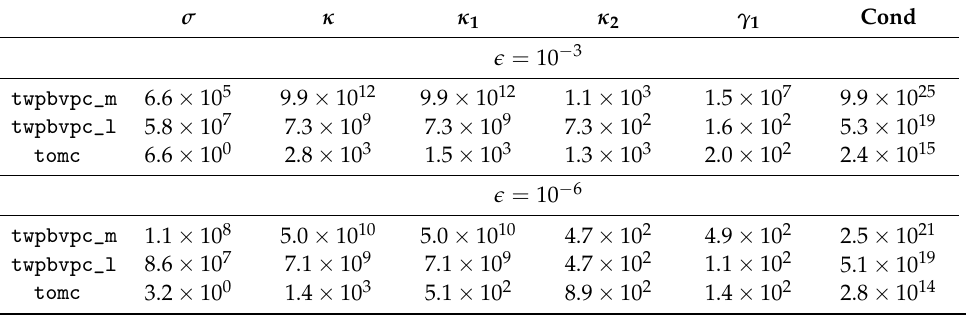
Figure 6. Minimization of the fuel cost in the operation of a train (cid:101) = 10 − 2 : from left to right solutions in time for the position x , the velocity v and the difference between the control variables representing the acceleration and the deceleration u a − u b . Table 23. Minimization of the fuel cost in the operation of a train: conditioning parameters computed using tol = 10 − 6 , cond is the condition number of the matrix associated with the last nonlinear